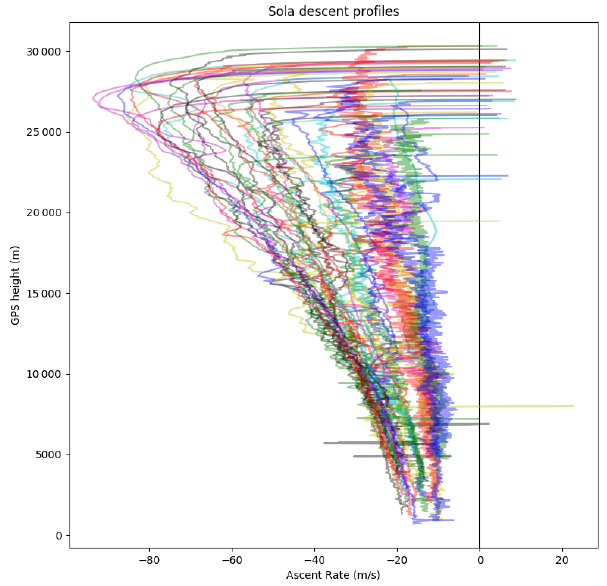
Figure 5. Descent profiles from Sola, Norway (data courtesy of Terje Borge) for 14 December 2019–5 January 2020.